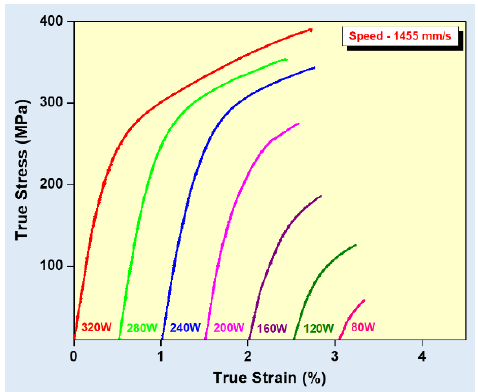
Figure 7. Room temperature tensile true stress-true strain curves of Al-12Si samples fabricated with decreasing laser power (320 W–80 W) at a constant laser scan speed (1455 mm/s) in an SLM solutions SLM 250 device [68]. Copyright 2017. Adapted as per the open access policy of Taylor and Francis group (Figure 1b [68]).